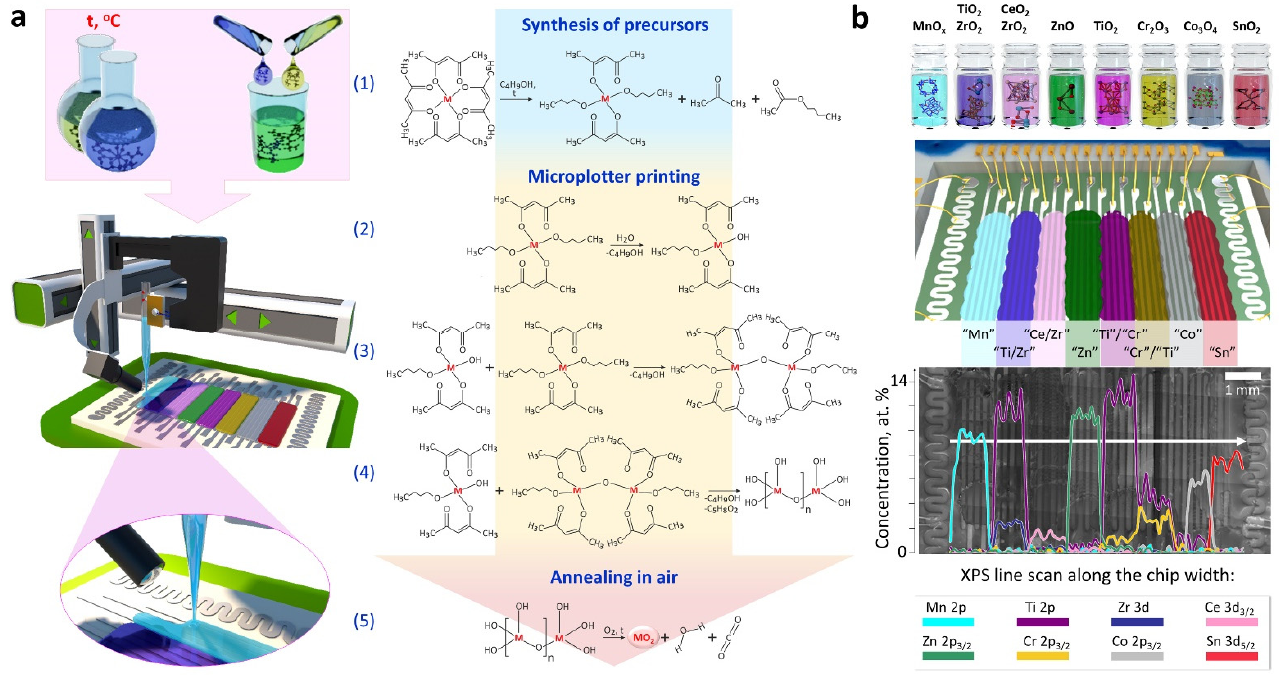
Figure 7. On-chip multioxide combinatorial library printed by microplotter: ( a ) Schematic illustration of the fabrication process including the cartoon of the experimental printing setup with a microplotter and chemical routes for heteroligand precursor synthesis (1), their hydrolysis (2), condensation (3), polycondensation (4), and oxide crystallization (5); ( b ) Chip prototype fabricated with oxides of the list drawn at the first line: the animation drawing and SEM image; the concentration of the different metal elements along the chip surface detected by XPS scanning in the direction indicated by a white arrow; the signals related to O 1s stemming from the substrate/printed layers and Si 2p from the substrate are not depicted here. Reproduced from ref. [107]. Copyright 2020, American Chemical